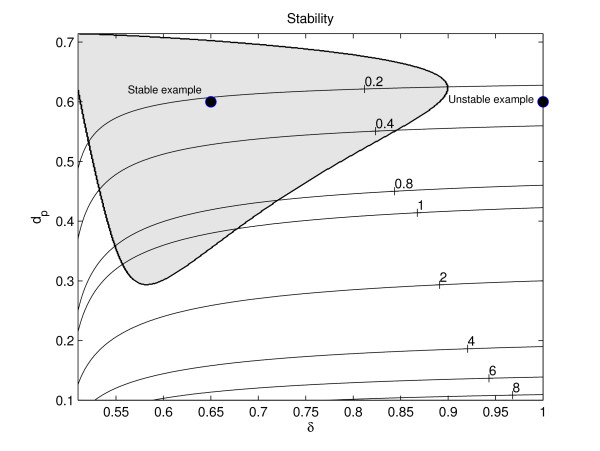
Partition of (δ, dp)-space based on stability of wave trains. Figure showing where in (δ, dp)-space (as determined by (A-7) in the Appendix (additional file 1)) the wake behind the invading wave of tumour cells is stable (shaded region) and where it is unstable (white region). The stability analysis requires ds ≈ , where  denotes the value of ds at which the Hopf bifurcation occurs; thus in our (δ, dp)-space we mark by solid lines contours where  (as calculated from (A-11) in the Appendix (additional file 1)) is constant (corresponding values are labelled on the contours). For a case of stability ((δ, dp) = (0.65, 0.6) and ds ≈ 0.2) tumour cell invasion into the spatially homogeneous vessel-only steady state results in regular spatio-temporal oscillations (see Figure 4), while in the case of instability ((δ, dp) = (1.0, 0.6) and ds ≈ 0.2), irregular spatio-temporal oscillations develop (see Figure 5). Key: shaded region: wave stability; white region: wave instability; solid lines: lines where  is constant. Parameter values: η0 = 0.5, sβ = 0.4 and σp = 0.